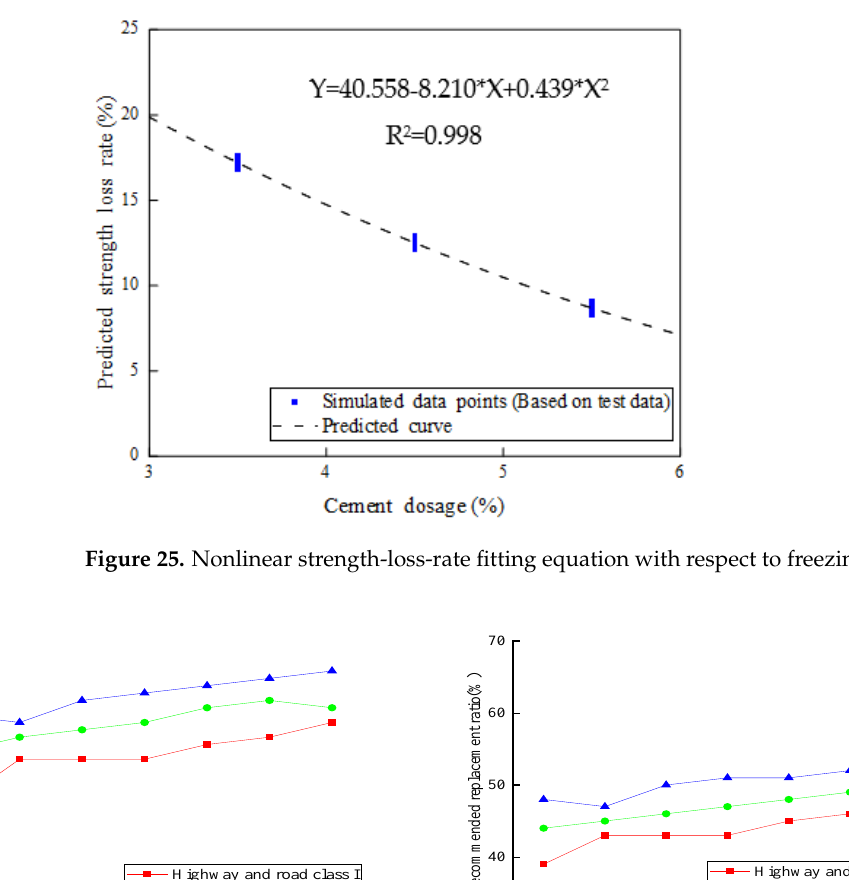
Figure 25. Nonlinear strength-loss-rate fitting equation with respect to freezing-damage effects.